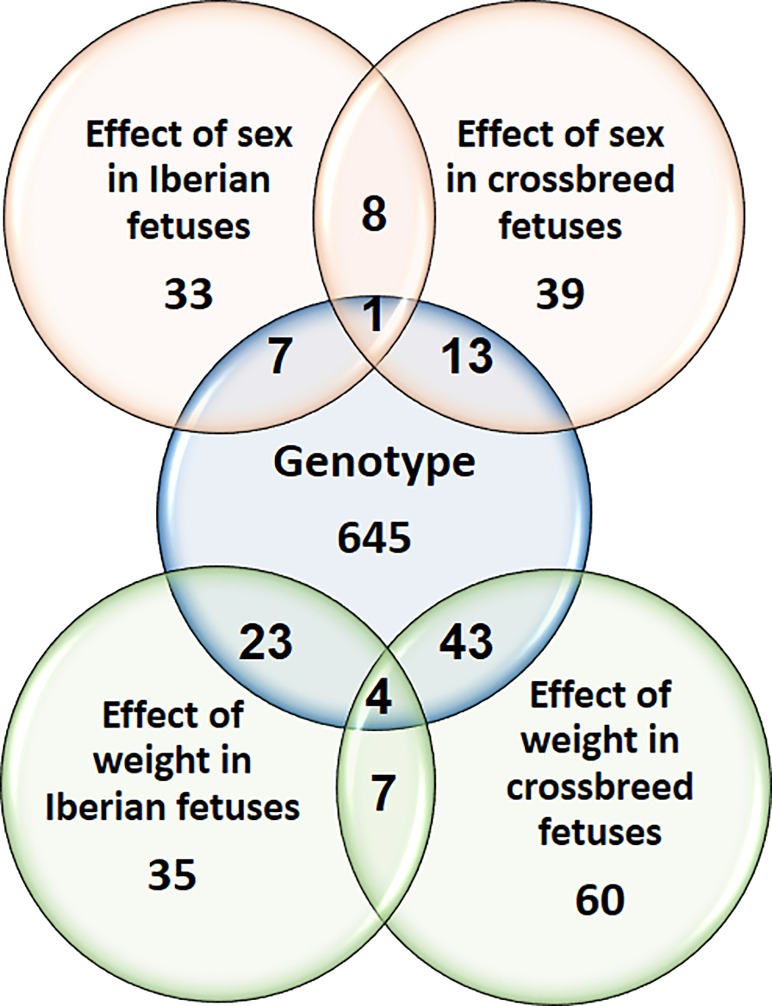
Venn diagram showing the total number of differentially expressed (DE) genes in all comparisons.